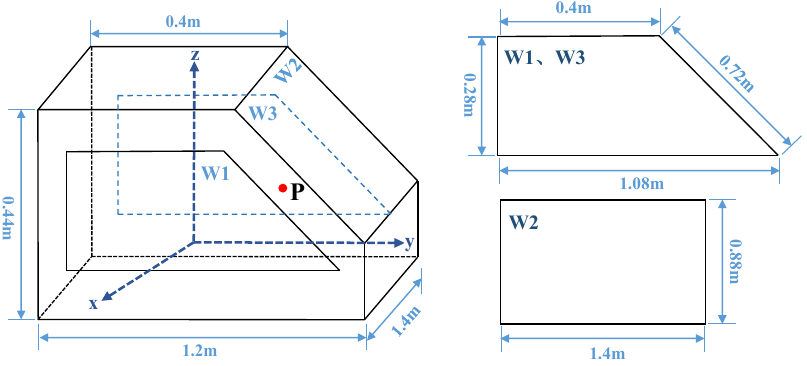
Figure 2. Geometry of 3-D vehicle cab.